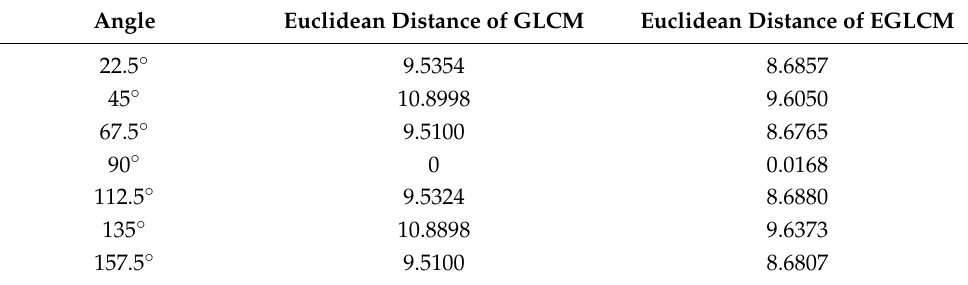
Table 9. Euclidean distances of GLCM and EGLCM with different angles.